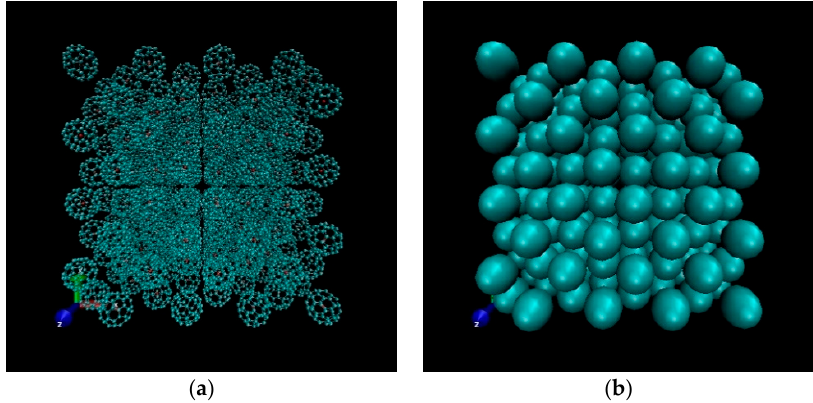
Figure 5. Initial state of C60 molecules in a molecular dynamics (MD) simulation. ( a ) All-atom model. ( b ) CG model.